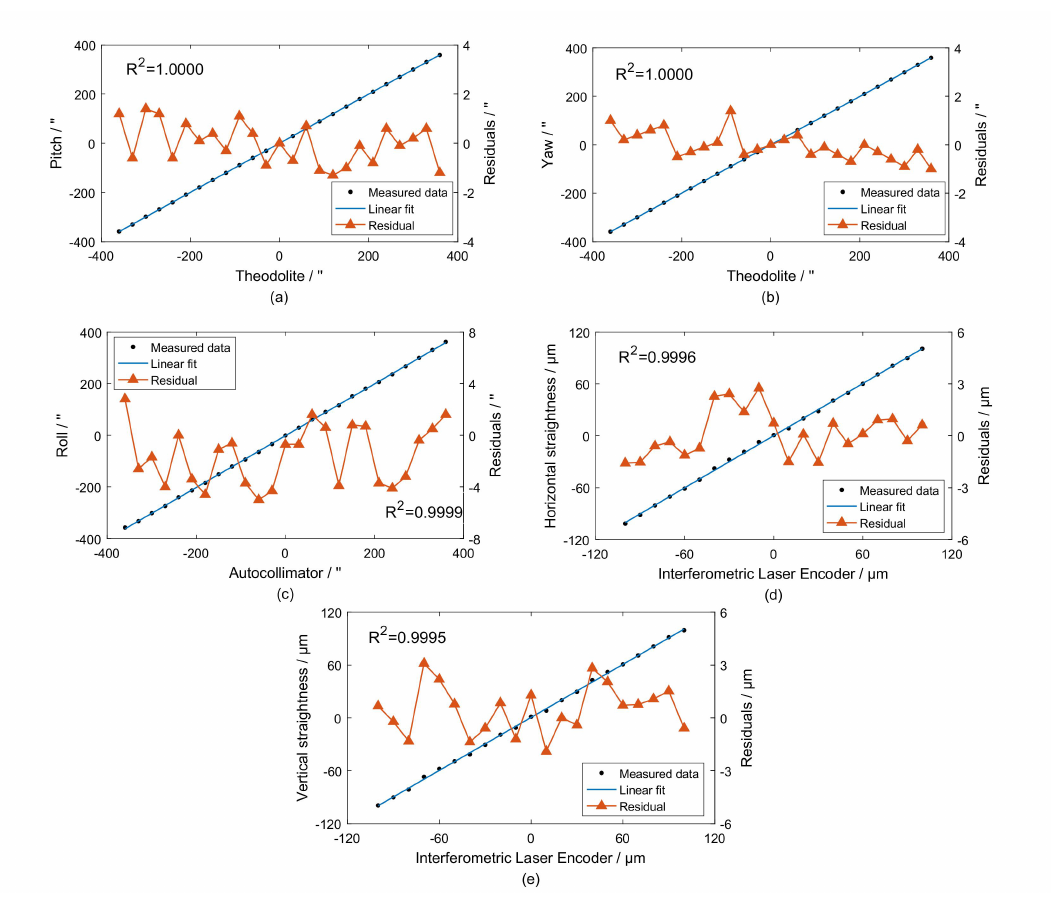
Figure 9. Calibration experiments. ( a ) Pitch. ( b ) Yaw. ( c ) Roll. ( d ) Horizontal straightness. ( e ) Vertical